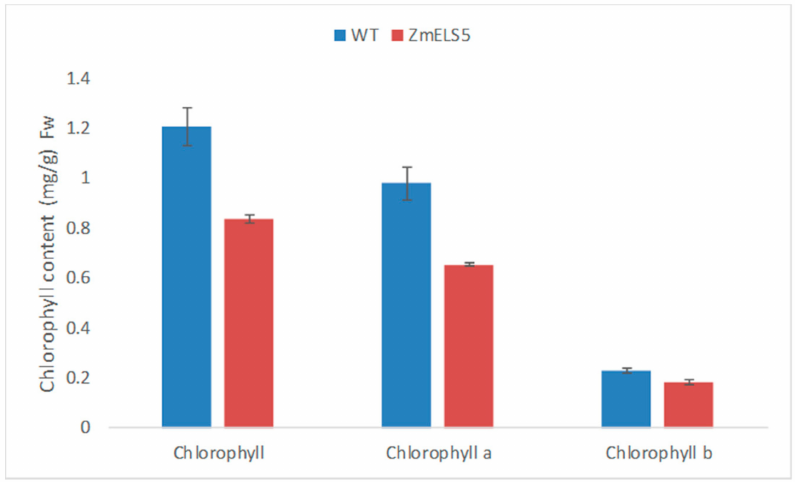
Figure 2. Chlorophyll contents in the leaves of WT and ZmELS5